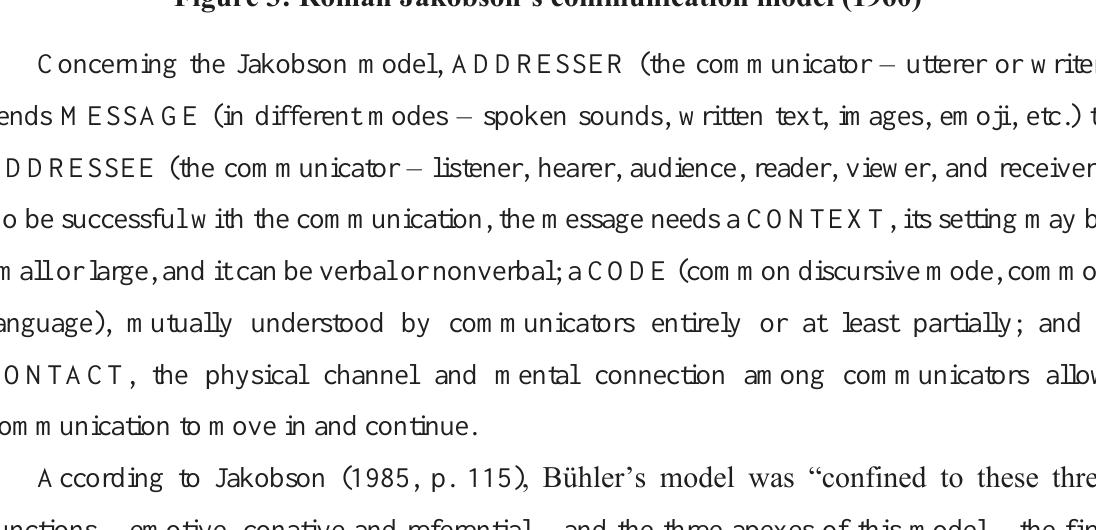
Figure 3: Roman Jakobson’s communication model